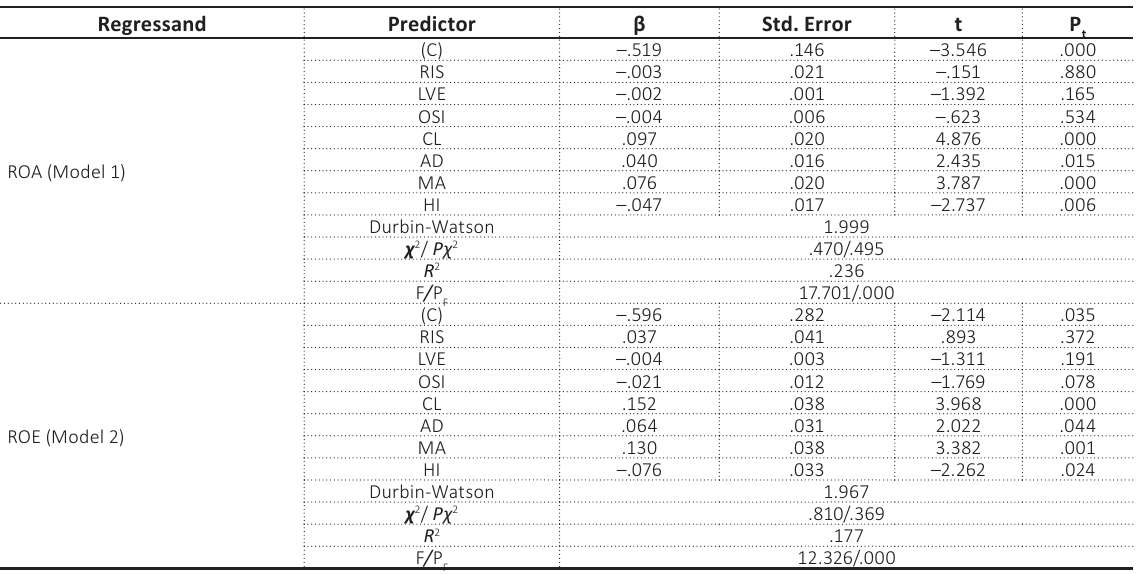
Table 4. Multiple regression analyses to test causal hypotheses